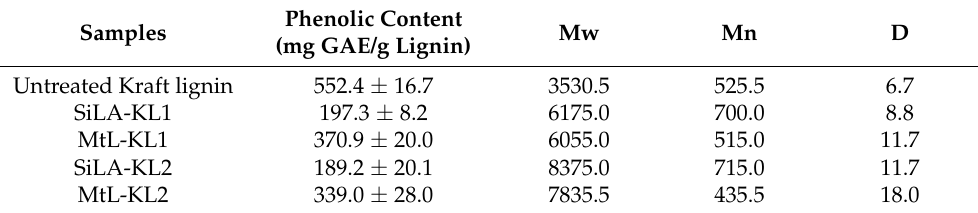
Table 1. Phenolic content, weight average (Mw) and number-average (Mn) molecular weights, and polidispersity (Mw/Mn) of untreated Kraft lignin and laccase-treated lignins. Mw and Mn are given in